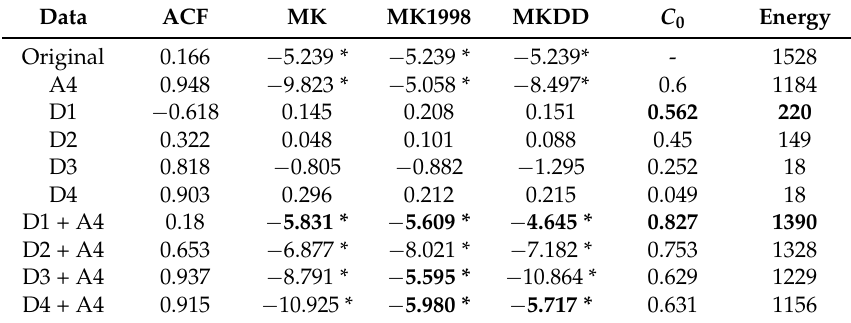
Table 8. Lag-one ACFs, Mann-Kendall values and energy of annual mean streamflow series: original data, detail components (D1–D4), approximations (A4) and a set of combinations of the details and their respective approximations. C 0 is the correlation coefficients between the decomposition combinations and the original